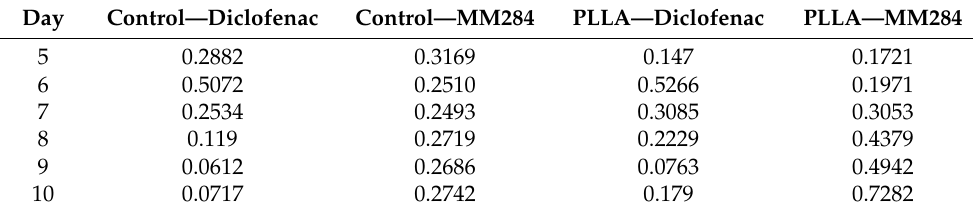
Figure 4. Clinical impedance measurements from day 0 to 28, divided into ( A ) contact one, ( B ) contact two, ( C ) contact three, and ( D ) contact four. Mean ± SD. Blue = Control group, pink = PLLA group, green = Diclofenac group, orange = MM284 group. Contact 4 ( D ) is closest to the cochleostomy, contact 1 ( A ) is the most apical. Significant differences are provided in Tables 3 and 4. Table 3. p values contact one.